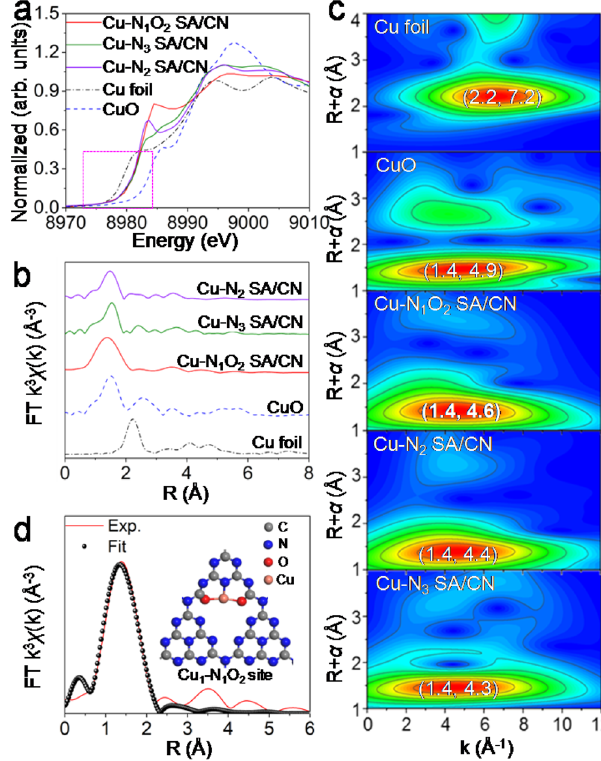
Fig. 3 | Characterization of local structure and electron properties of single- atom catalyst. a Normalized Cu K -edge XANES spectra and b corresponding k 3 - weighted Fourier Transform spectra of as-prepared samples. c Wavelet transform of Cu-N 1 O 2 SA/CN, Cu foil, CuO, Cu-N 2 SA/CN and Cu-N 3 SA/CN. d EXAFS fi tting curve in R space and the model of Cu 1 -N 1 O 2